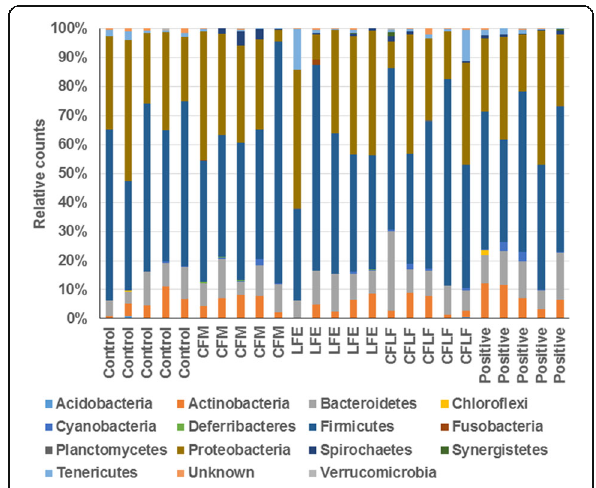
Fig. 5 Proportion of taxonomic assignments [Phylum] for gut microbiomes. Control, OVX rats fed a high-fat diet (HFD) with 1% dextrin; CFM, OVX rats fed an HFD with 1% lyophilized cauliflower mushroom; LFE, OVX rats fed an HFD with 0.1% L . fermentum plus 1% dextrin; CFLF, OVX rats fed an HFD with 1% CFM plus 0.1% L . fermentum ; positive-control,